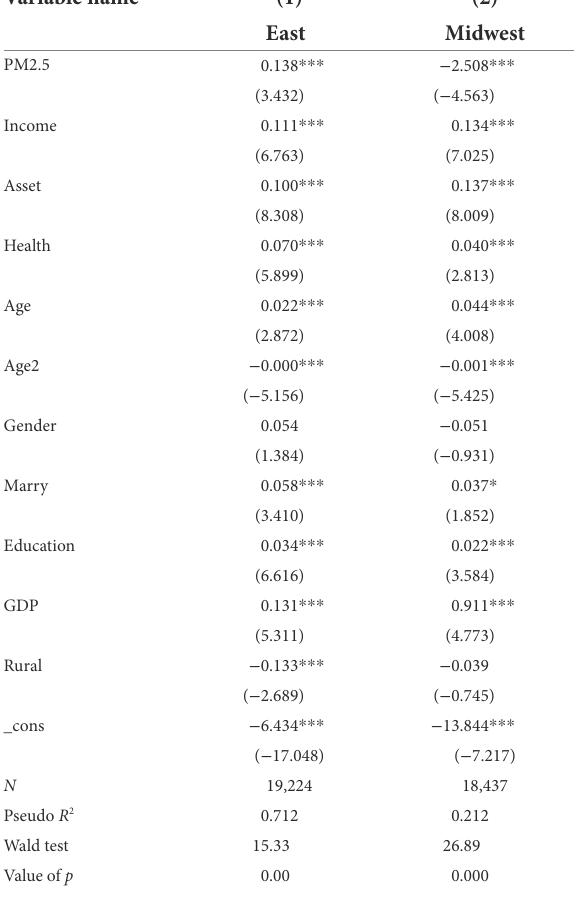
TABLE 7 Regional difference analysis of the impact of haze pollution on demand for commercial health